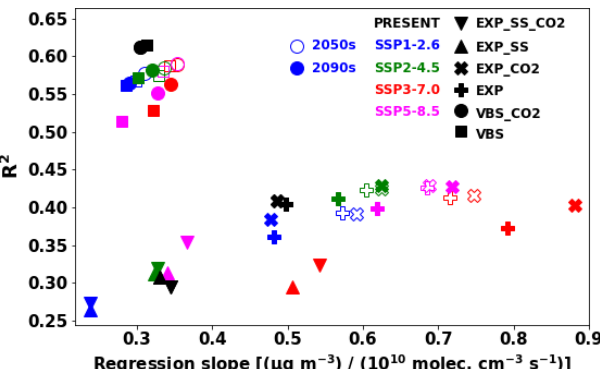
Figure 14. Regression slope and R 2 values between IEPOX SOA (or VBS SOA) concentrations at the surface and isoprene emissions. Monthly mean values at each model grid point were used for the calculation. The different symbols indicate the different model con- figurations, with filled symbols for the 2090s and open symbols for the 2050s. The colors represent the SSP scenarios (or present con- ditions) as shown in the